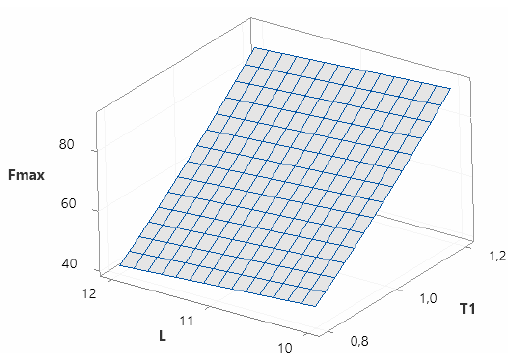
Figure 11. Surface plot of ν and T 1; T 2 (for L = 11 mm)